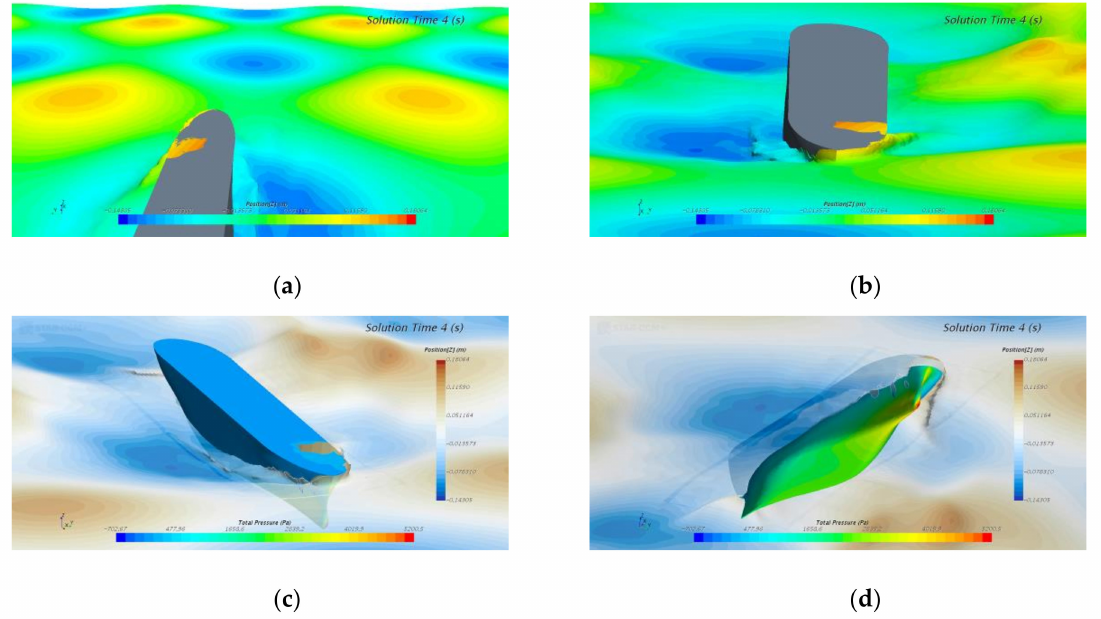
Figure 28. View of ship wave interaction in the asymmetric wave field ( t = 4 s): ( a ) deck view; ( b ) front view; ( c ) top view; ( d ) bottom